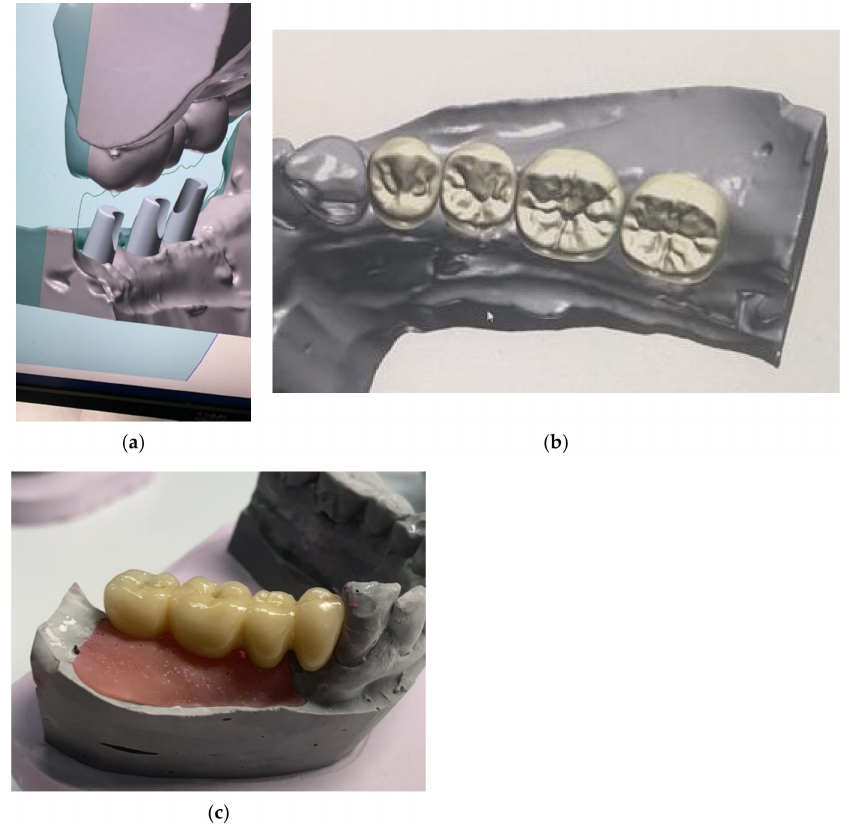
Figure 19. Prosthetic planning and design ( a – c